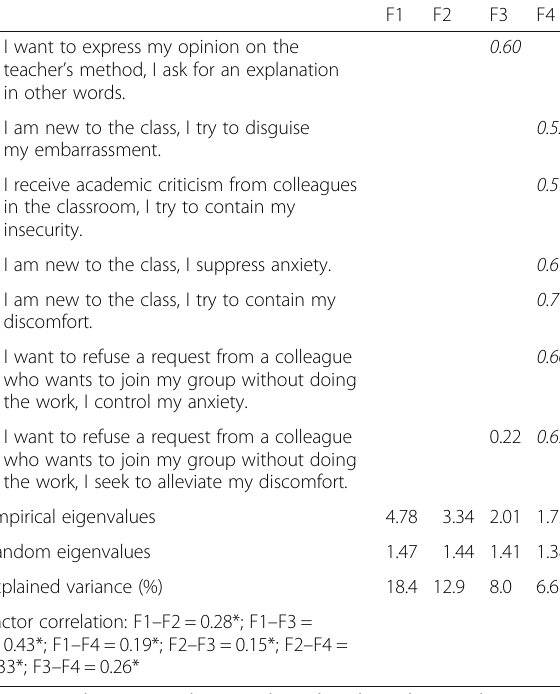
Table 4 Factor analysis (Principal Axis Factoring) relating items and factors extracted